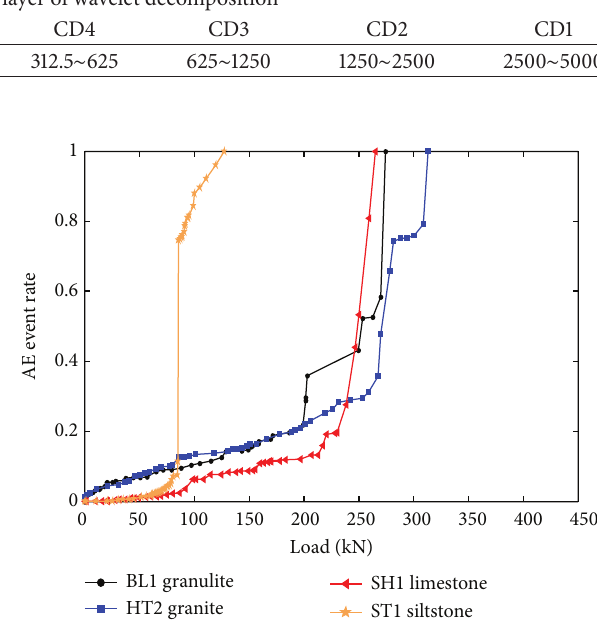
Figure 8: The curves of the accumulated AE counts and load for the four specimens.